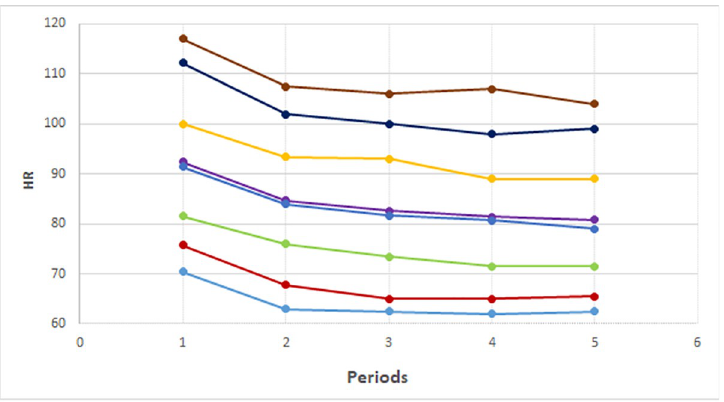
Fig 2. Graph showing percentile heart rate values according to the period after delivery (HR = heart rate in bmp). Periods: 1 = 0–20 min, 2 = 21–40 min, 3 = 41–60 min, 4 = 61–90 min, 5 = 91–120 min. Percentiles: p5;p10;p25;p50;